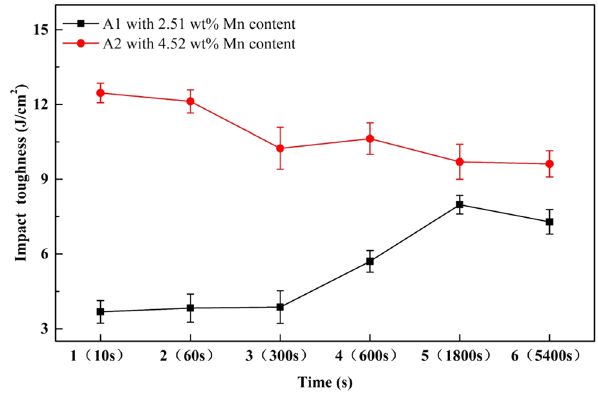
Figure 8: Impact toughness changes of alloys A1 and A2 with dif - ferent carbon